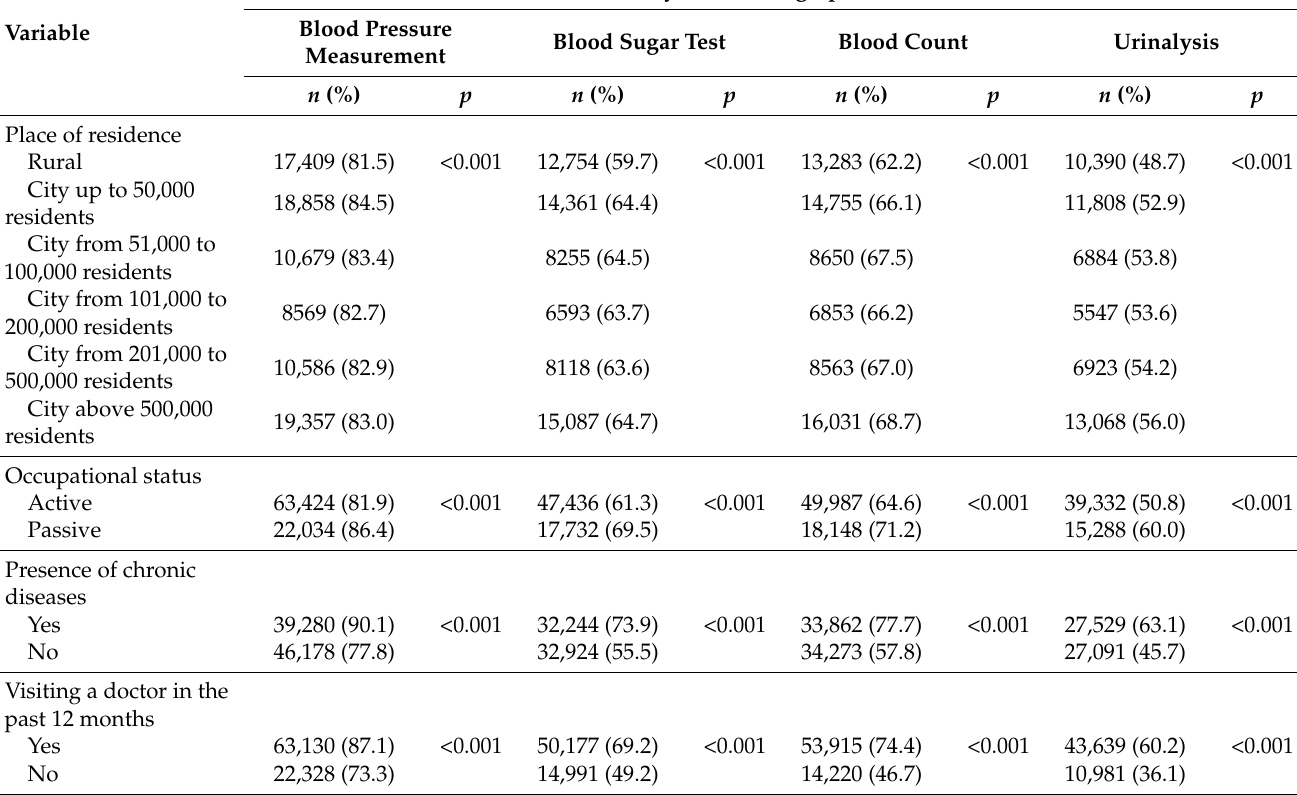
Table 4. The percentage of females in Poland who performed cervical cytology in the last 3 years by sociodemographic factors ( n =